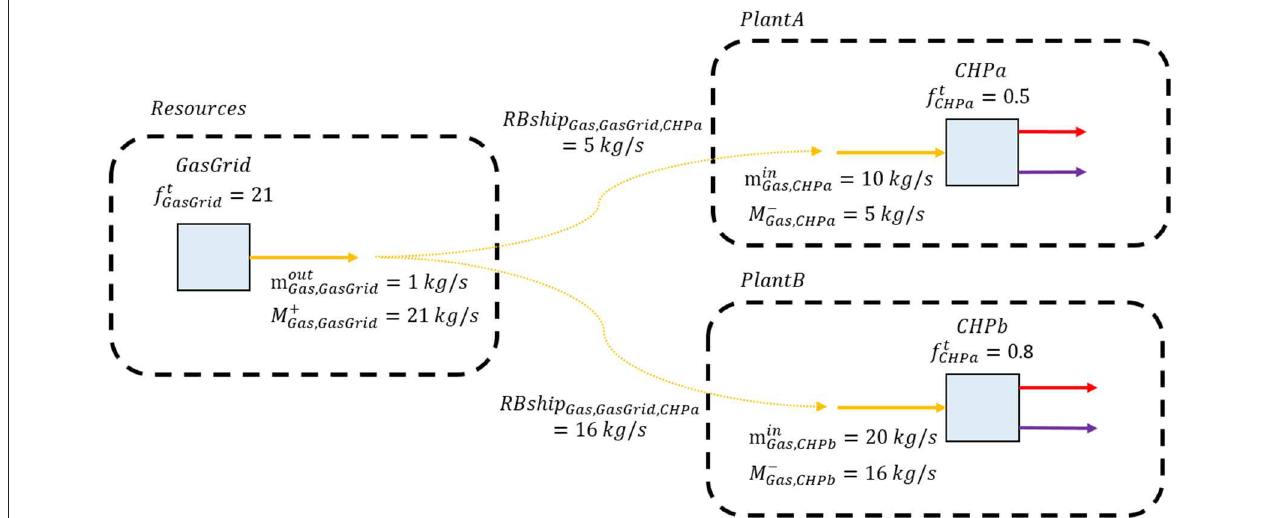
FIGURE 4 | Illustrative example of a rb layer